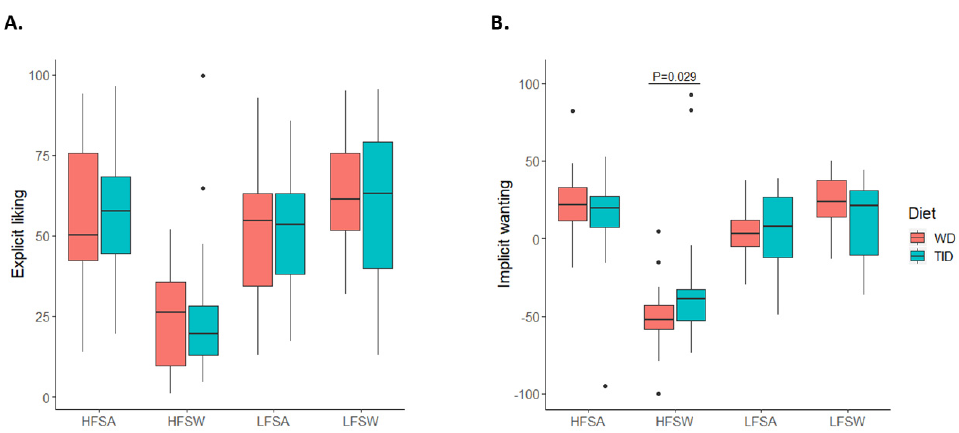
Figure 4. Liking and wanting for different food categories stratified by diet. Explicit liking ( A , n = 44) and implicit wanting ( B , n = 43) for the four combined food categories: high-fat savoury foods (HFSA), low-fat savoury foods (LFSA), high-fat sweet foods (HFSW), and low-fat sweet foods (LFSW). Coloured boxes represent median and IQR, whiskers represent Q1 − 1.5*IQR and Q3 + 1.5*IQR, and dots represent outliers. WD, Westernised diet; TID, traditional Inuit diet; IQR, interquartile range.